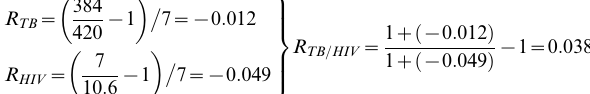
HIV increases HIV constant HIV